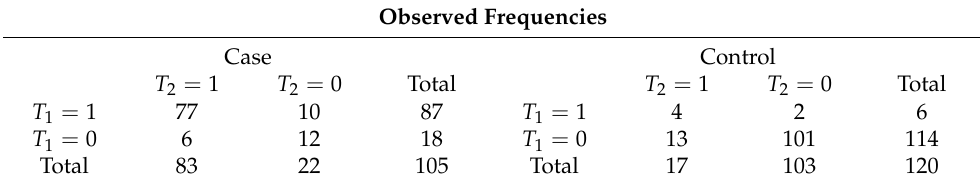
Table 9. Diagnosis of coronary heart